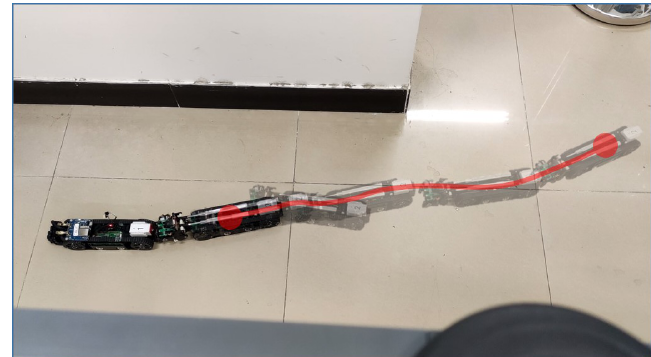
Figure 14. SMMRob docking experiments and the path of the moving robot.